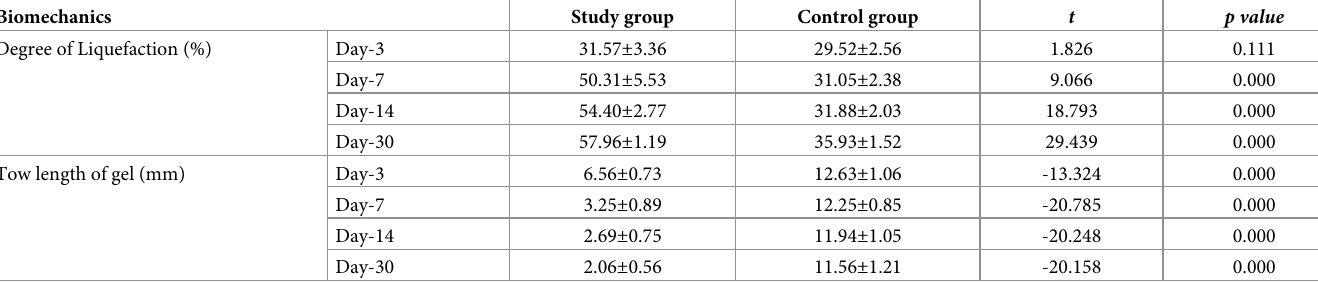
Table 2. Comparison of biomechanical characteristics of binocular vitreous at different time intervals (n = 8, � x � ± s).